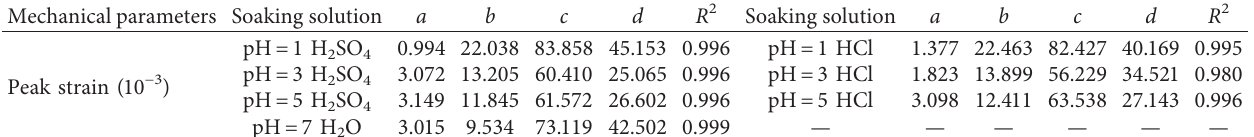
Table 5: Fitting parameters of relationship between peak strain and soaking time. Mechanical parameters Soaking